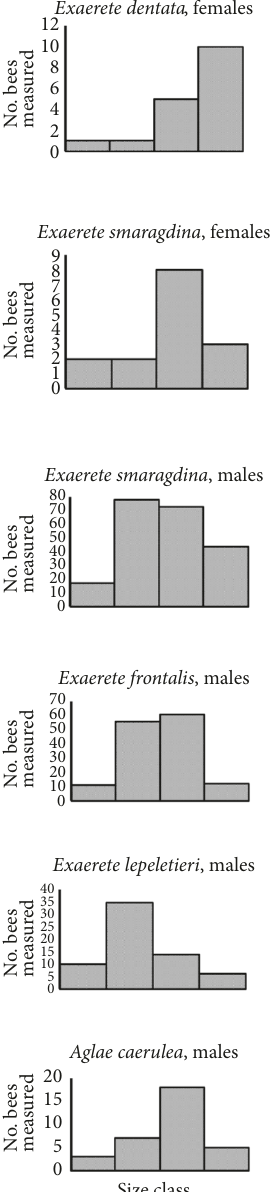
Figure 1: Frequency histograms showing size distributions of parasitic euglossine adult females and males. Measurements usually converted from inches to mm; size categories combined here, for uniformity across species (see Methods); measurements and statistics given in Table